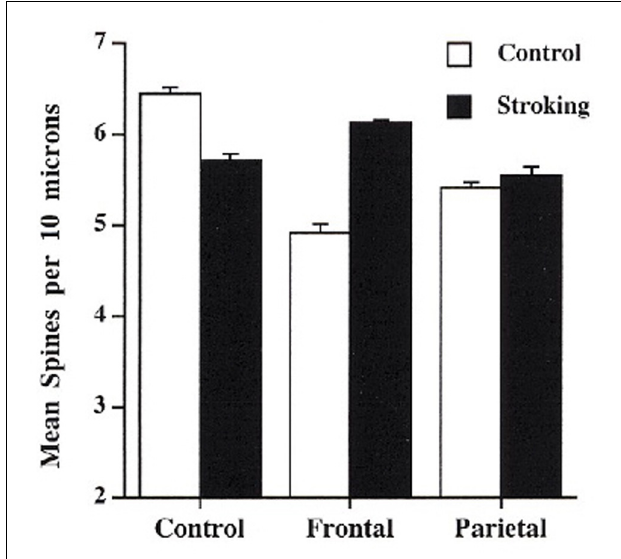
FIGURE 3 | Effect of tactile stimulation (stroking with a fine brush) on spine density in control, day 3 frontal injury, and day 3 parietal injury in rats (After Kolb and Gibb,